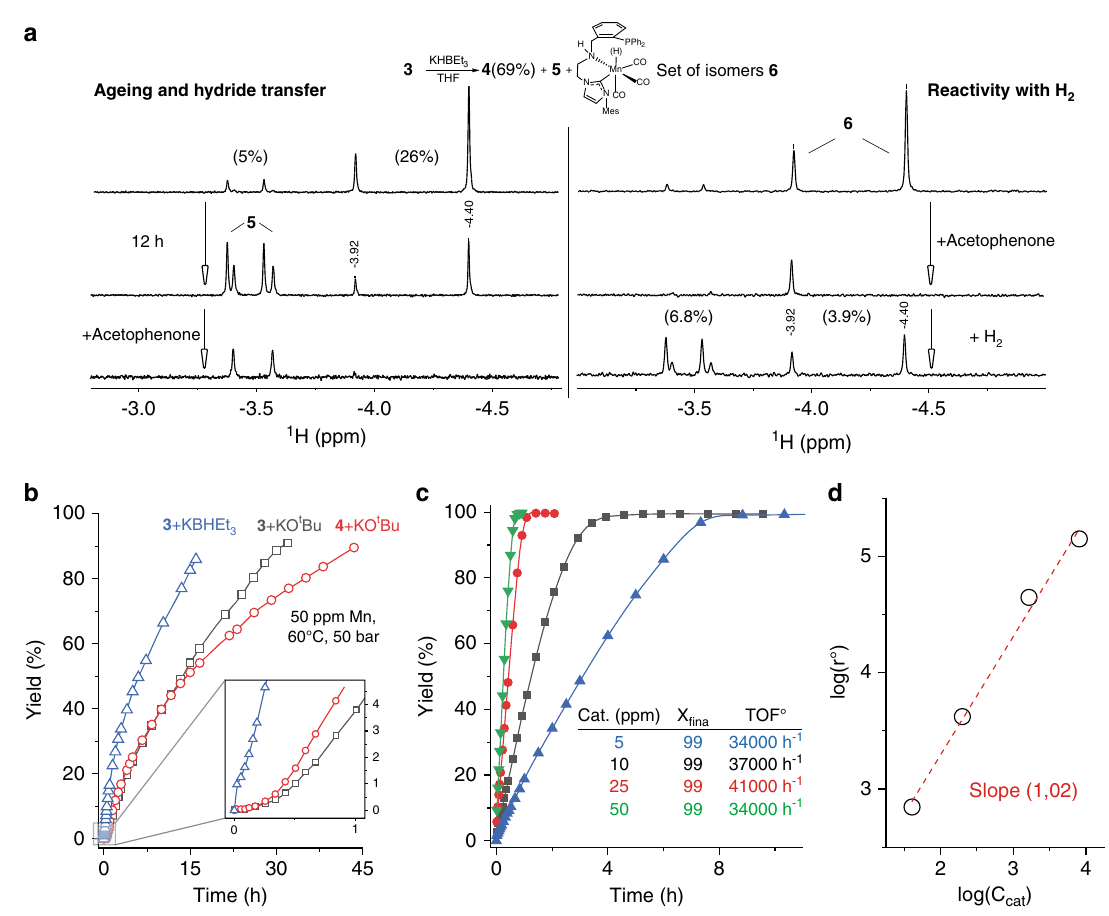
Fig. 4 Catalyst activation with KBHEt 3 and corresponding catalytic performance. a 1 H NMR spectra of the hydride region for KHBEt 3 activated complex 3 . Left panel shows slow conversion of 6 to complex 5 and subsequent reactivity with acetophenone; right panel shows reactivity of species 6 with acetophenone and regeneration of reactive hydride species in H 2 atmosphere (see Supplementary Figs. 32 – 35 for details); relative content of hydride species indicated in percent units of total Mn. b Kinetic traces for the hydrogenation of acetophenone with complexes 3 and 4 in the presence of 1 mol% KO t Bu or 1 mol% KHBEt 3 promoters at 60 °C, 50 bar H 2 , and 50 p.p.m. Mn loading. c Kinetic traces of acetophenone hydrogenation with 3 at different